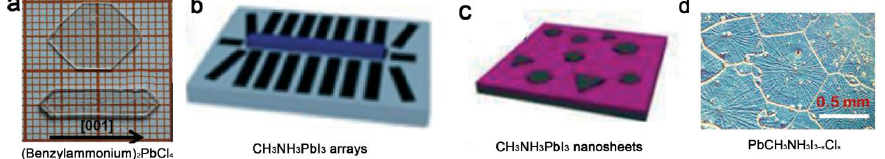
Figure 5. ( a ) Slow evaporation method produces the (benzylammonium) 2 PbCl 4 perovskite single crystal; ( b ) Arrays of CH 3 NH 3 PbI 3 single crystal; ( c ) 2D MAPbI 3 perovskite nanosheets; ( d )